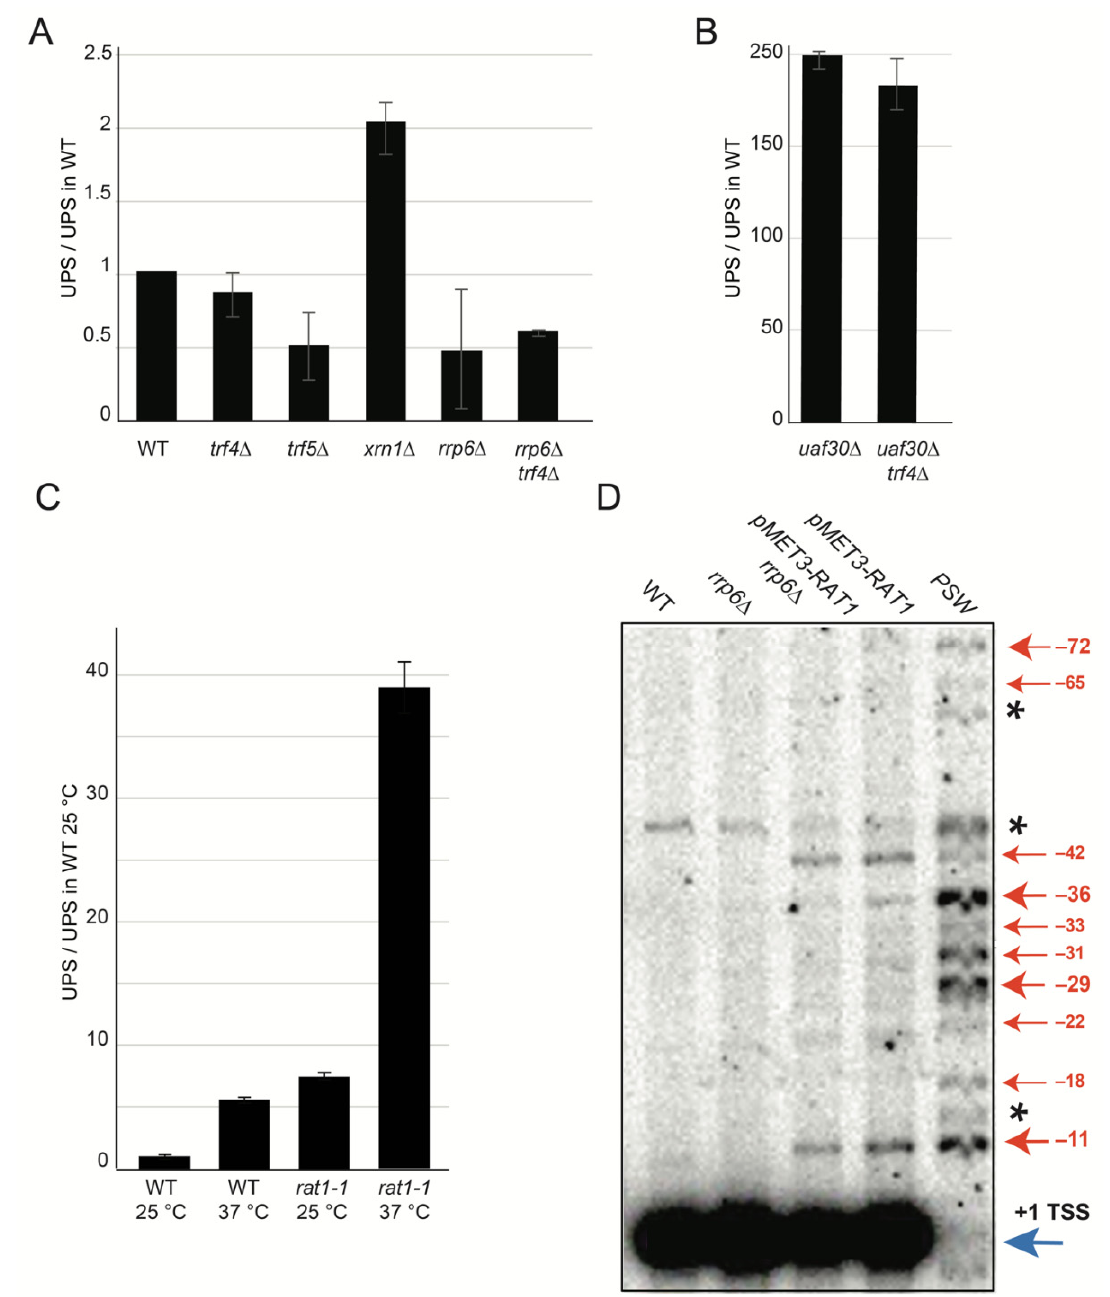
Figure 2. UPS are unstable lncRNAs degraded by Xrn1 and Rat1 5 ′ -3 ′ exoribonucleases. ( A ) UPS accumulate in xrn1 ∆ but not in exosomes ( rrp6 ∆ ) or in the TRAMP complex ( trf4 ∆ , trf5 ∆ ) mutants. Yeast cells were exponentially grown in YPD medium at 30 °C overnight. Quantification of UPS in RNA decay mutants using qPCR and primers are described in Figure 1B. Quantities of UPS in mutants are represented as a ratio to UPS quantities in wild type. Error bars correspond to the standard deviation of two or three independent cultures. ( B ) UPS accumulation in uaf30 ∆ and uaf30 ∆ trf4 ∆ mutants. UPS were quantified as described in ( A ). ( C ) UPS accumulate in rat1-1 mutated strain. WT and rat1-1 strains (BY4741) were grown overnight at 25 °C to early exponential phase and then shifted to 37 °C for 6 h. Quantification of UPS in RNA decay mutants using qPCR. Quantities of UPS in mutants are represented as a ratio to UPS quantities in wild type at 25 °C. Error bars correspond to standard deviation of two independent cultures. ( D ) Visualization of UPS in Rat1-depleted cells. Cells were cultivated in YPD medium than switched to YPD+ 6 mM methionine for 12 h. Primer extension reaction with radiolabeled RT primer (Figure 1B) was resolved in 10% denaturating acrylamide gel. UPS are marked by red arrows and +1 TSS is marked by the blue one (please note the saturated exposure of +1 TSS signal). Star (*) represents non-specific RT product.